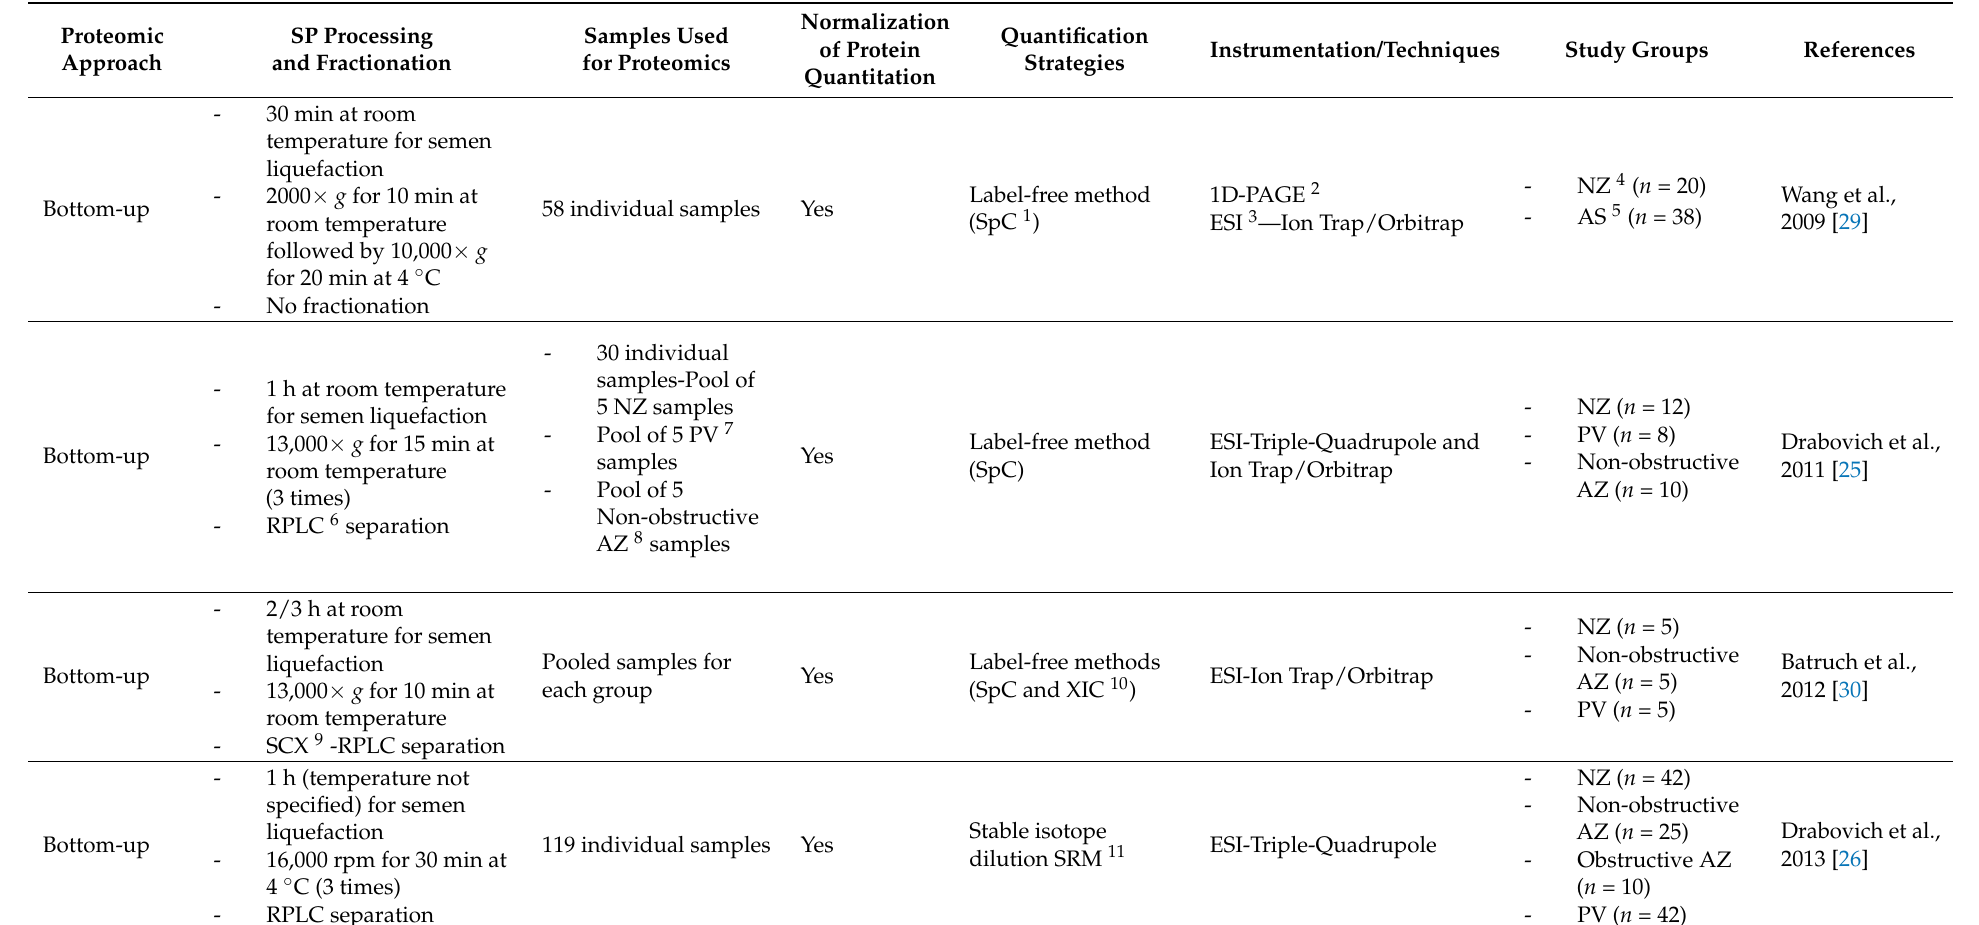
Table 1. Bottom-up and top-down MS-based proteomics studies on human